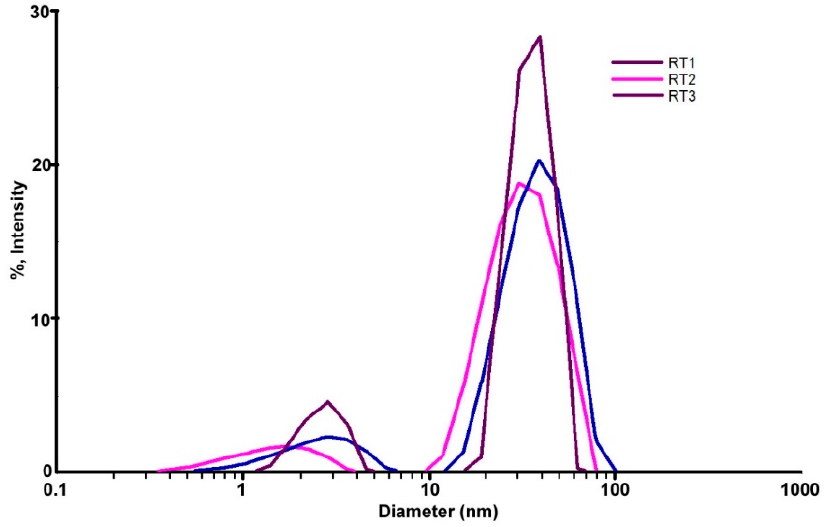
Figure 4. Superposed DLS images for samples obtained by chemical reduction at the room temperature .